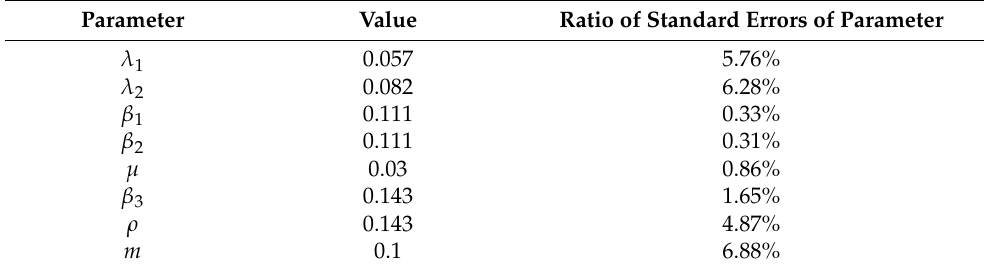
Table 6. Model estimated parameter values of stage